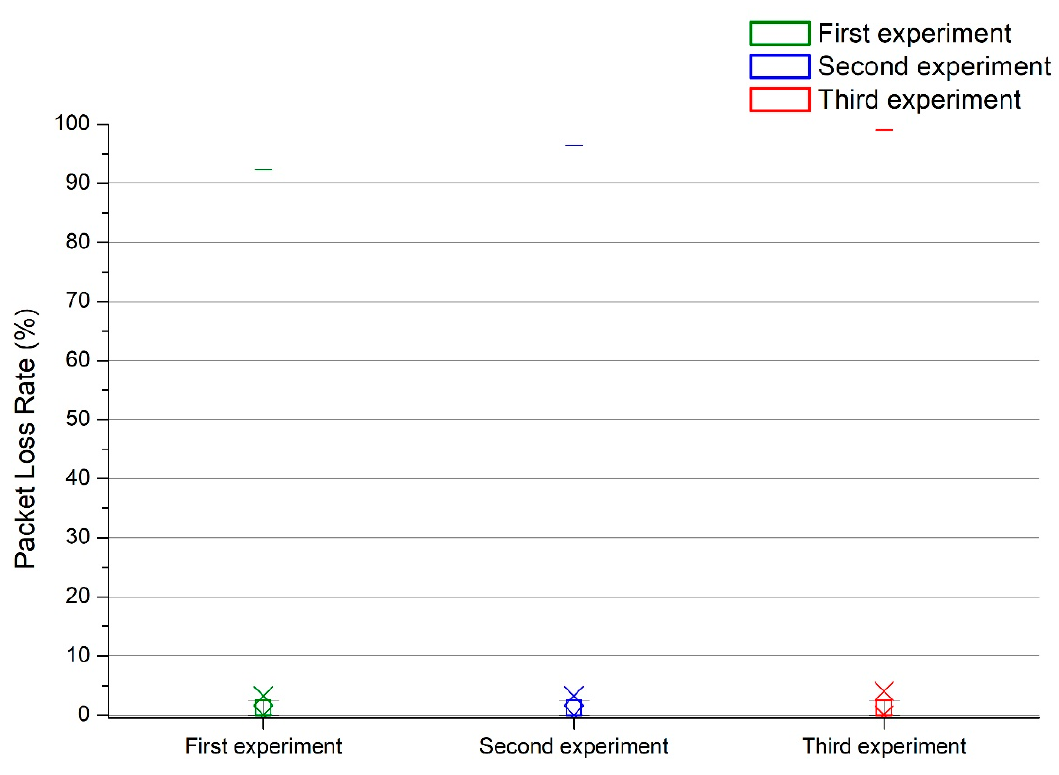
Figure 24. The confidence interval of packet loss rates of three experimental results for the LTE event A3 handover mechanism.